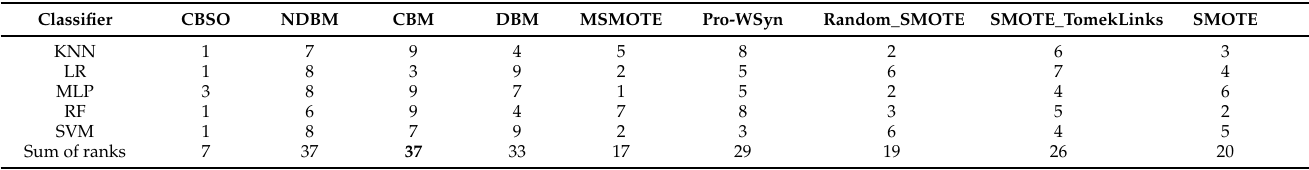
Table 11. Friedman sum-of-ranks test on ADL-based results for all methods and classifiers. CBM is the overall highest ranking method.